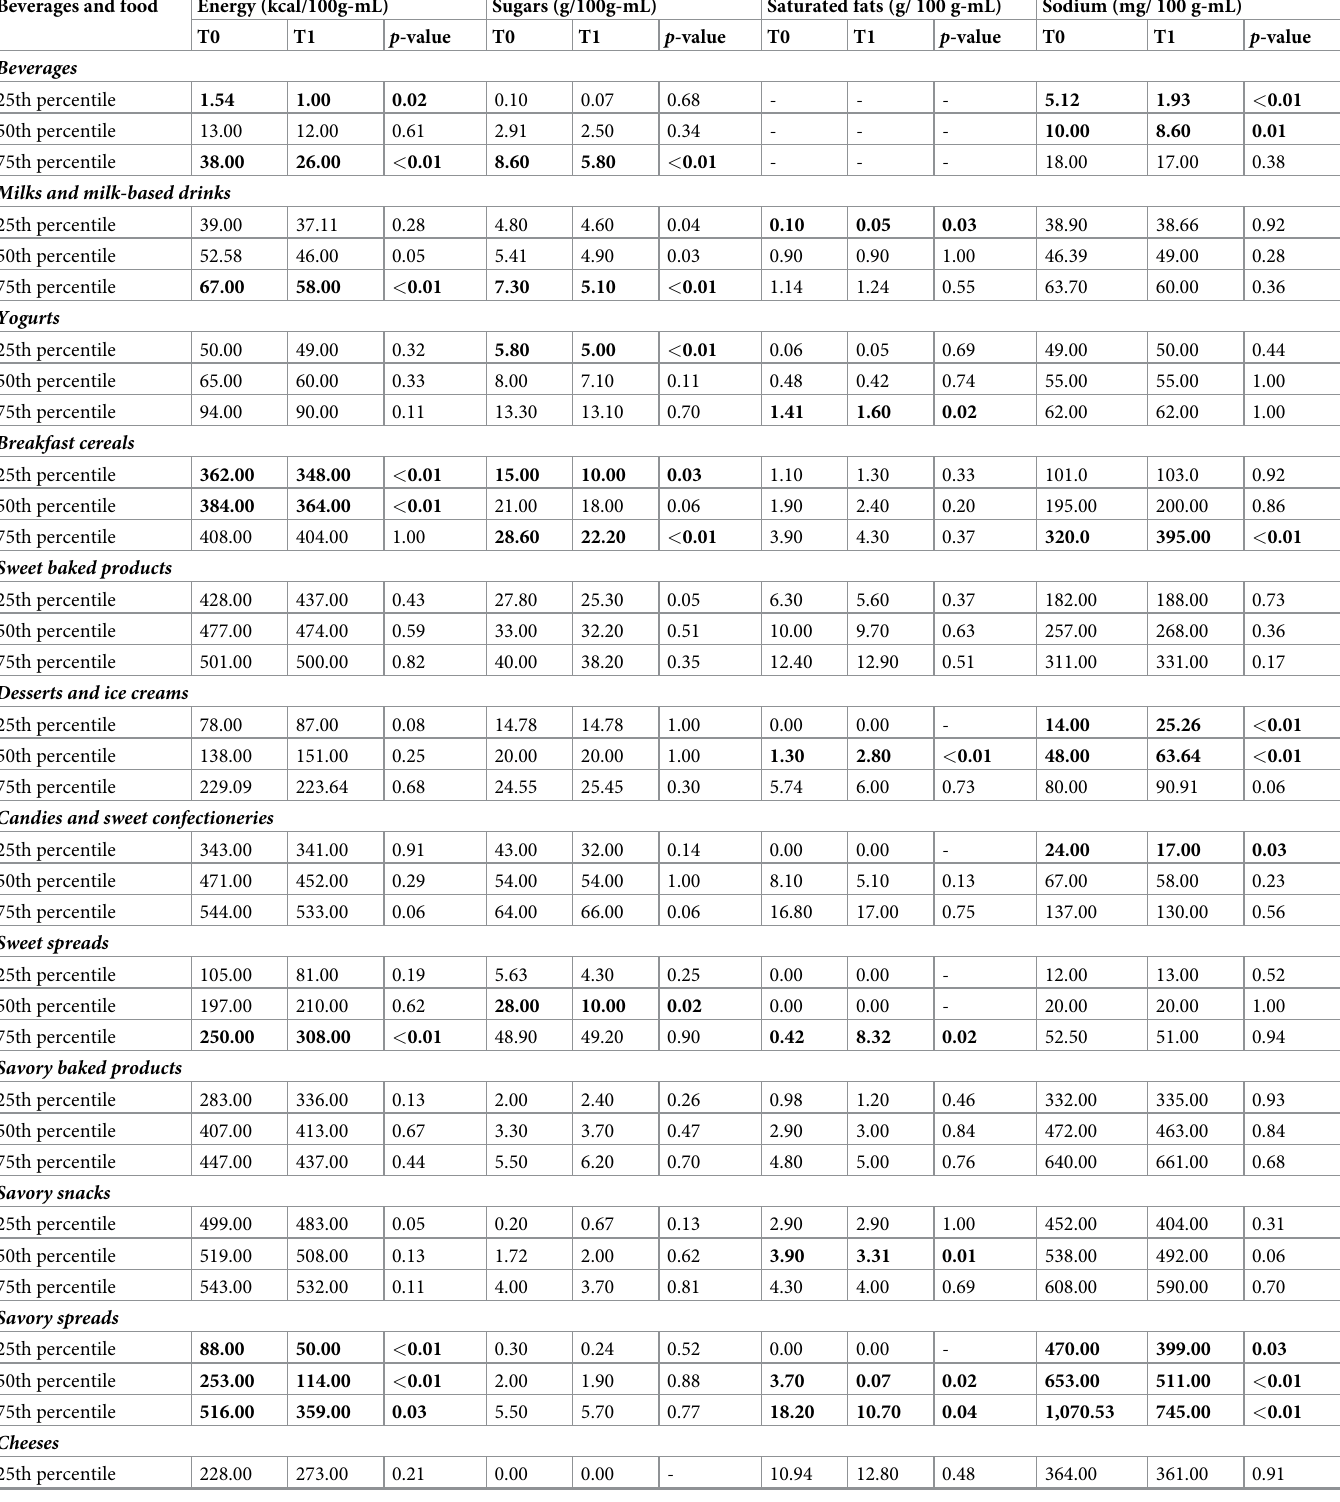
Table 2. Changes in quartiles of energy and nutrients of concern by food/beverages group; cross-sectional analysis. Beverages and food